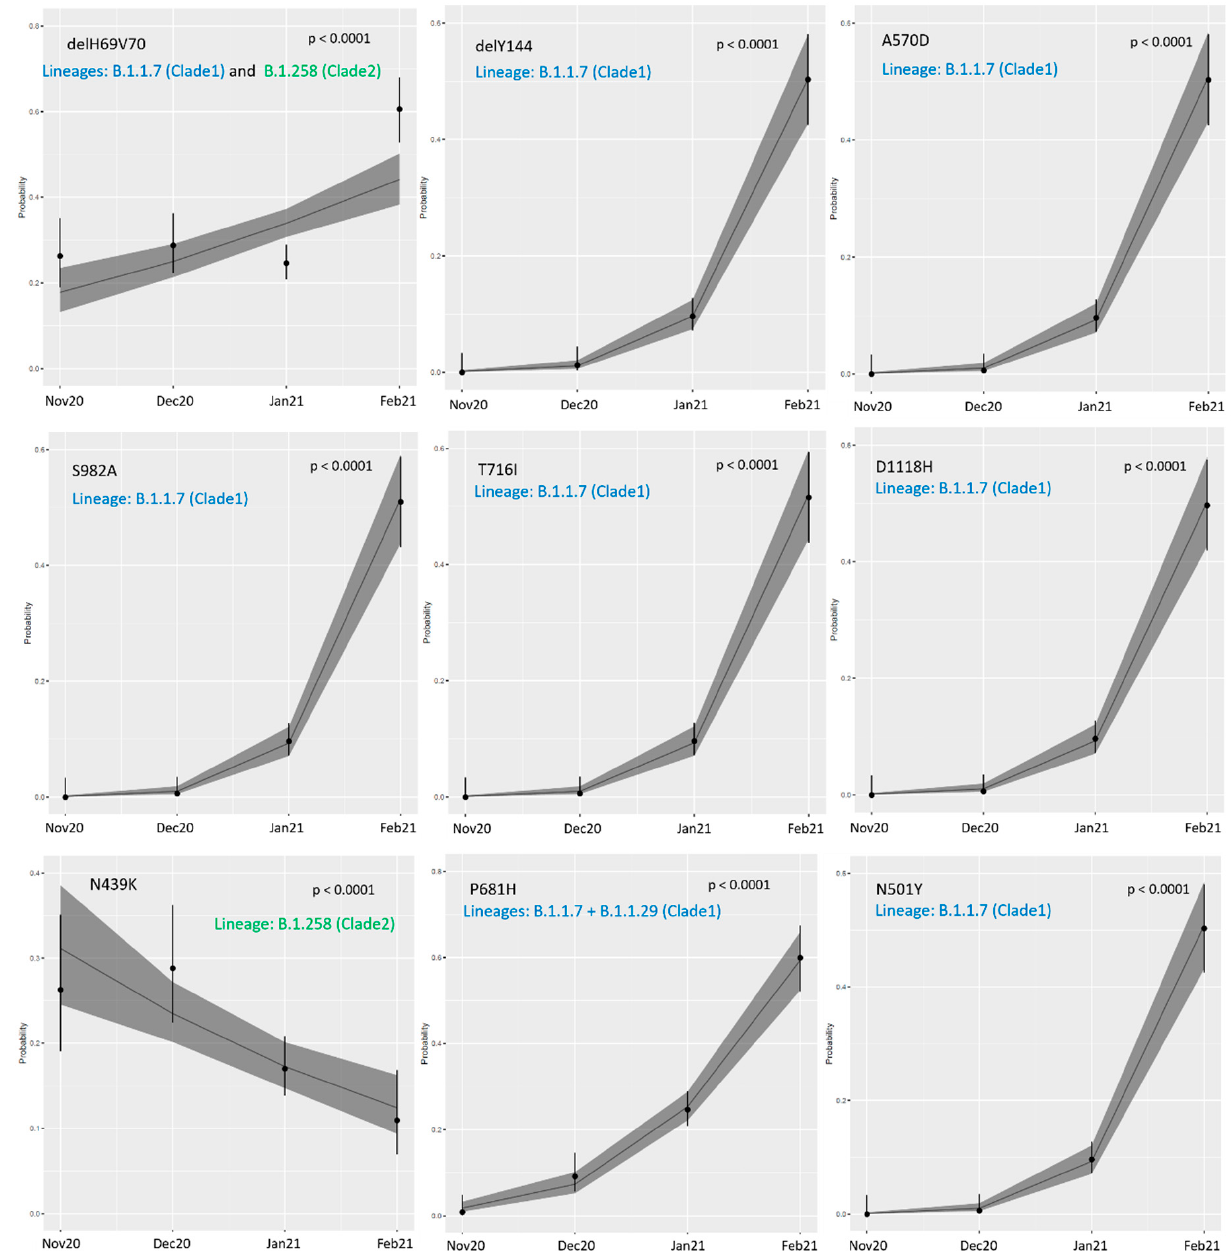
Figure 7. Logistic regression estimates for time trends between November 2020 and February 2021 for spike protein mutations identified in Polish isolates. Colored font describes lineages in which mutations was found. Table 2. Time trends for missense mutations in spike protein.